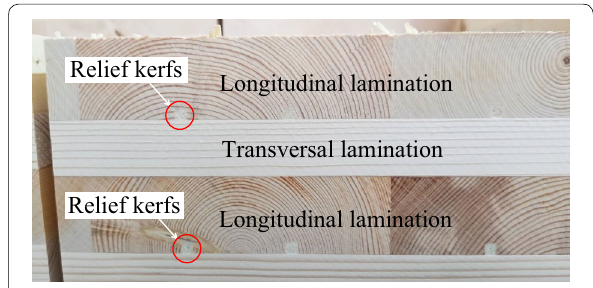
Fig. 1 Relief kerfs sawed in the CLT longitudinal laminations